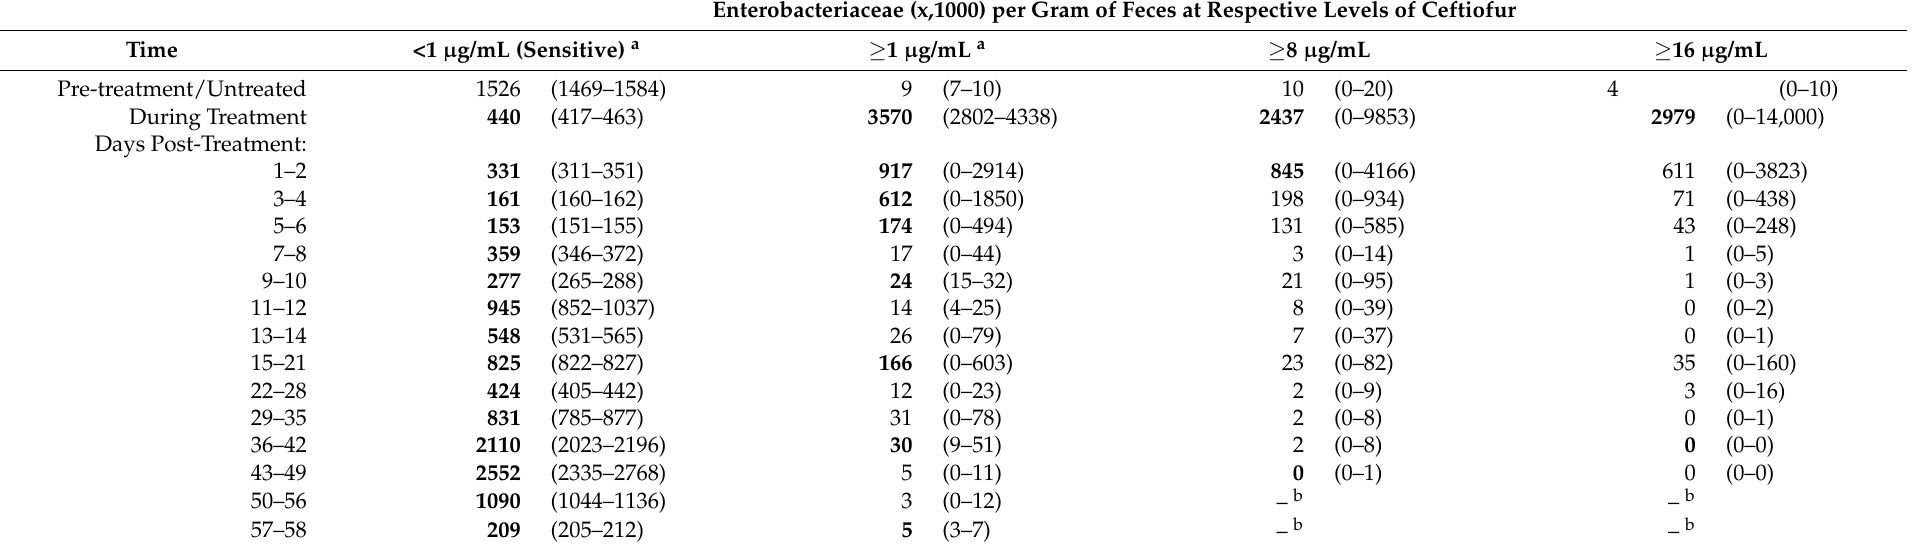
Table 5. Prediction estimates based on multilevel mixed effect negative binomial models of Enterobacteriaceae counts post-systemic antimicrobial drug treatment at four different levels